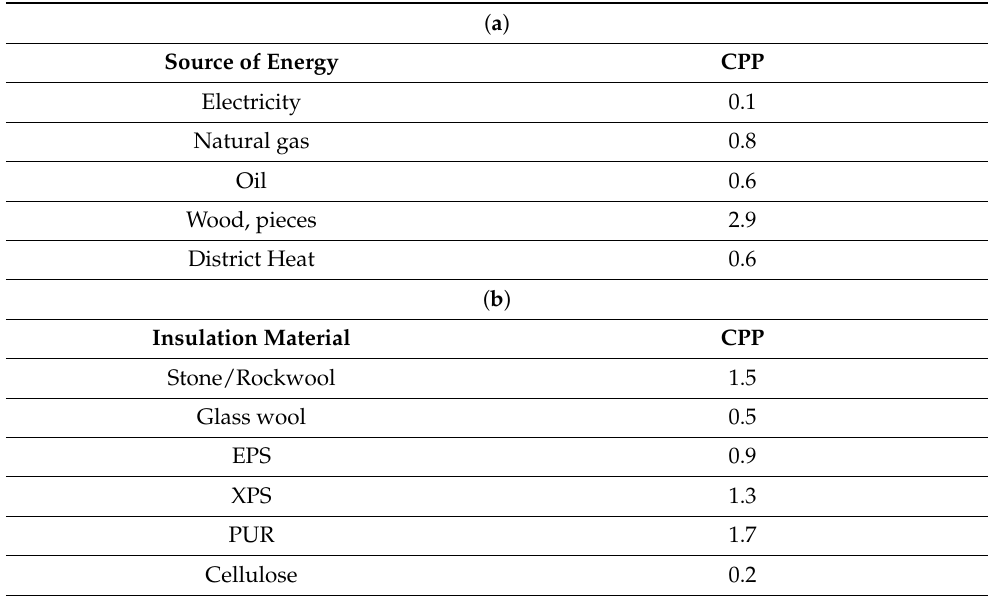
Table 10. ( a ) Average CPP values for different energy sources. ( b ) Average CPP values for various insulation